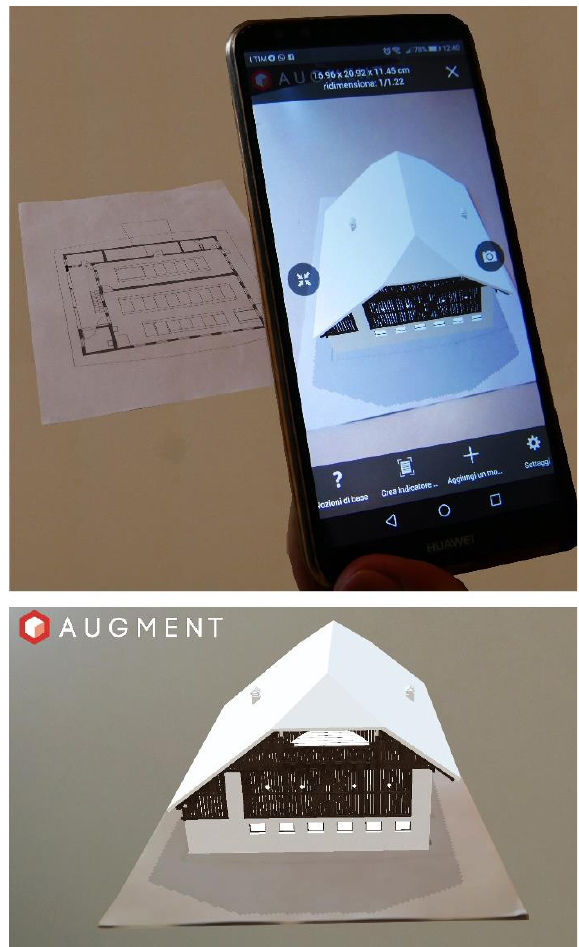
Figure 6: AR images of the Aschnerhof